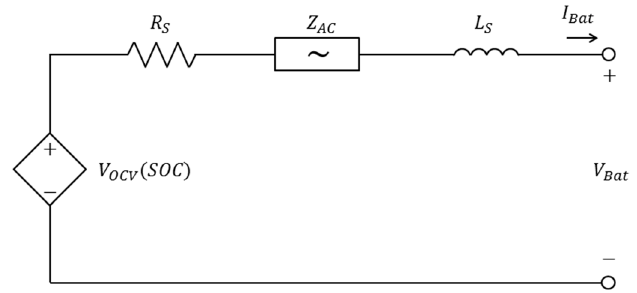
Figure 4. Impedance-based model .